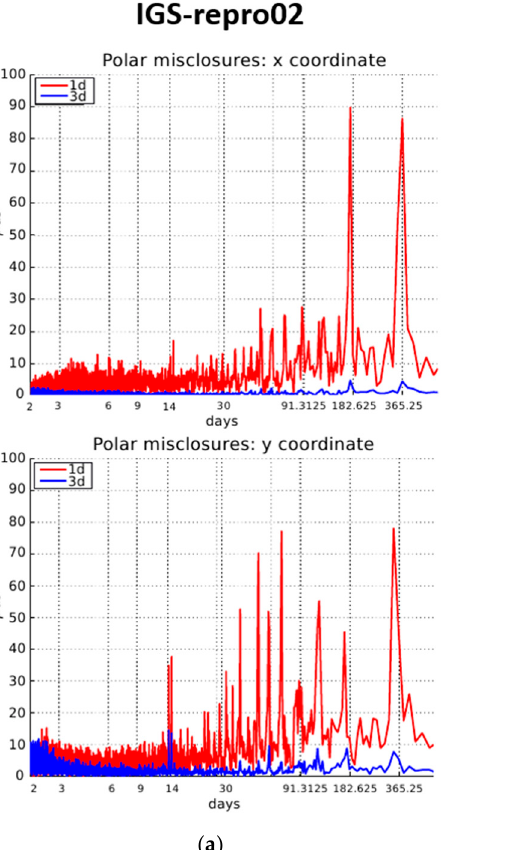
Figure 5. ( a ) Power spectrum of polar motion misclosures referring to the 2 nd IGS reprocessing campaign (IGS-repro02). ( b ) Power spectrum of polar misclosures referring to the reprocessing campaign carried out in the frame of the EGSIEM project (EGSIEM-REPRO). Misclosures in x coordinates are shown on the top and misclosures in the y coordinates are shown on the bottom, plotted with a shift along the vertical axis for clarity. Polar motion misclosures referring to the 1-day solution are shown in red, while polar motion misclosures referring to the 3-day solution are presented in blue. In both cases, the chosen time interval is 2000–2014.